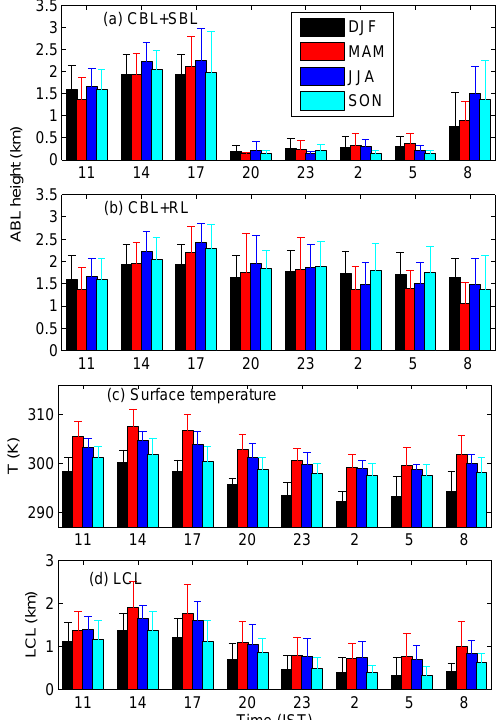
Figure 10. The diurnal variation of (a) the ABL CS (CBL + SBL) height, (b) the ABL CR (CBL + RL) height, (c) the surface tempera- ture, and (d) the LCL height during different